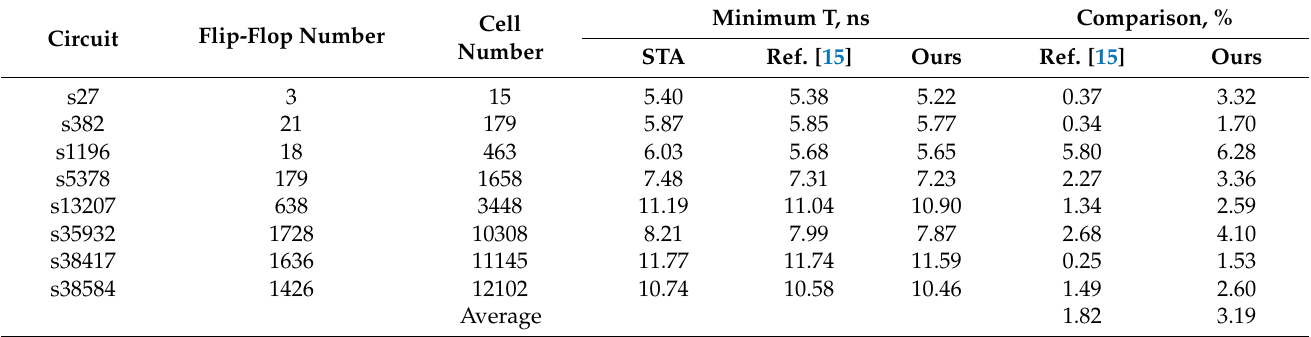
Table 2. Comparison of timing optimization for ISCAS’89 benchmark